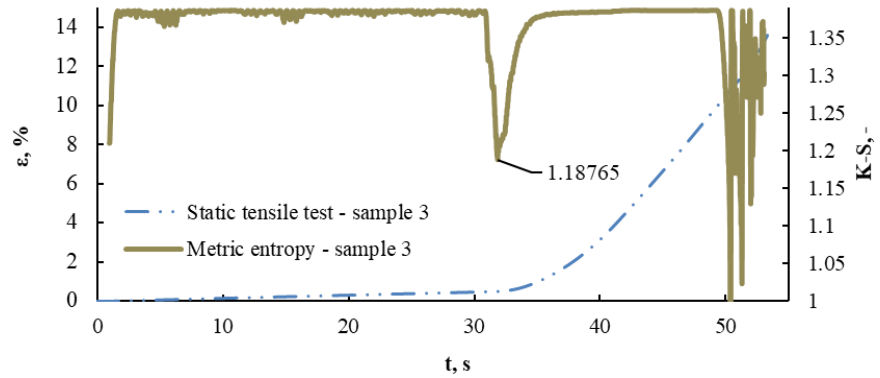
Figure 10. Diagram of metric entropy K-S and deformation ε as a function of time for Sample No. 3.